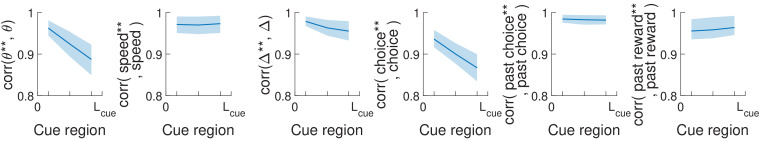
Pearson’s correlation between uncorrelated behavioral modes (θ**, speed**, etc.) and the corresponding most similar task variable (θ, speed, etc.).These uncorrelated modes were computed via polar decomposition as explained in the Materials and methods. Bands: standard deviation across imaging sessions.